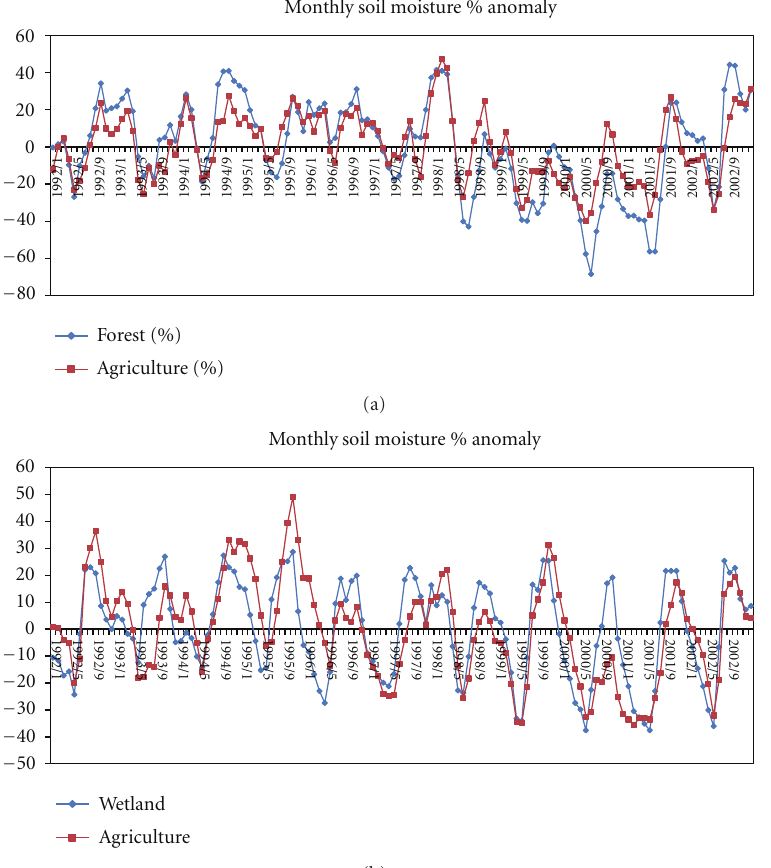
Figure 10: (a) The monthly 0–200 mm soil moisture anomalies in Northeast Florida. (b) The monthly 0–200 mm soil moisture anomalies in South